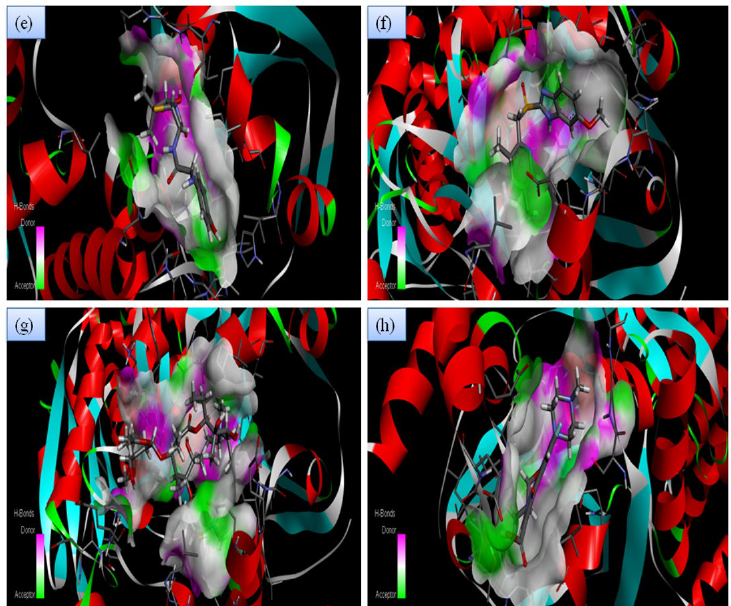
Fig. 3B. H-Bonding interaction of compound with the active site of Chorismate synthase protein (1UMF). (e) Amoxicillin (AMX). (f) Esomeprazole (EMP). (g) Azithromycin (AZM). (h) Levofloxacin (LEV).